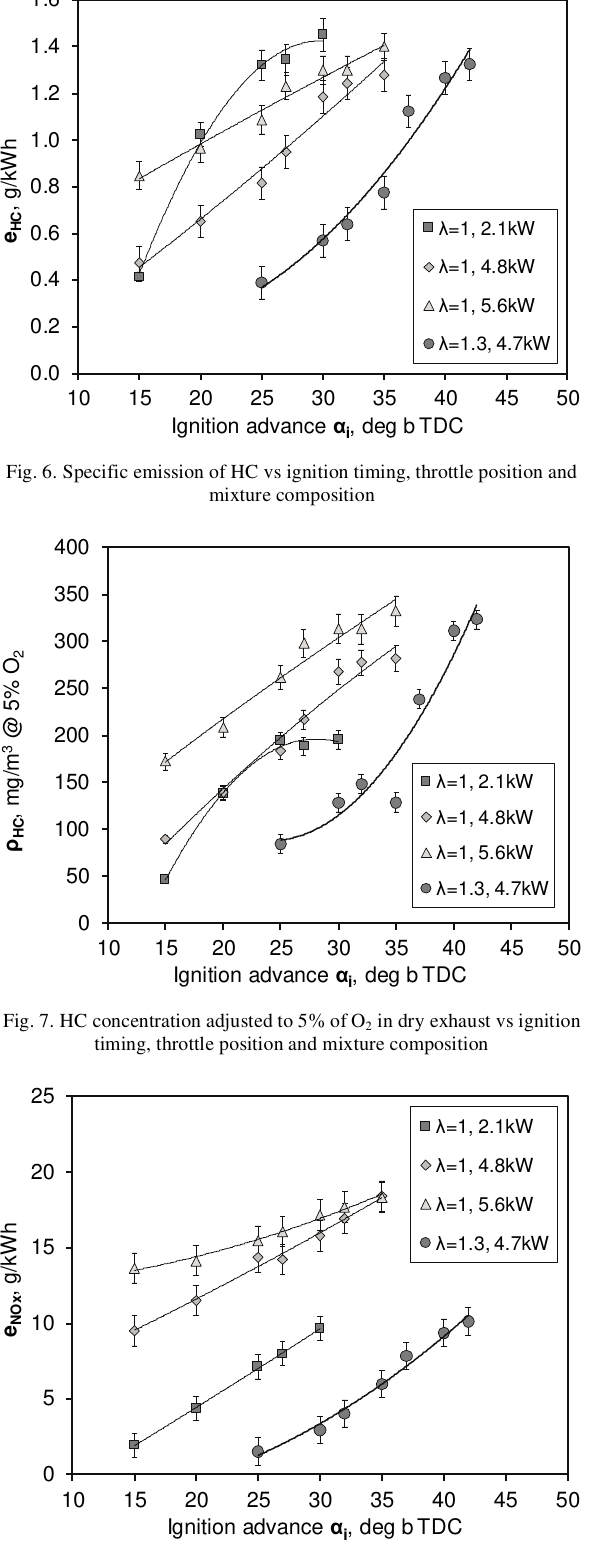
Fig. 8. Specific emission of NO x vs ignition timing, throttle position and mixture composition